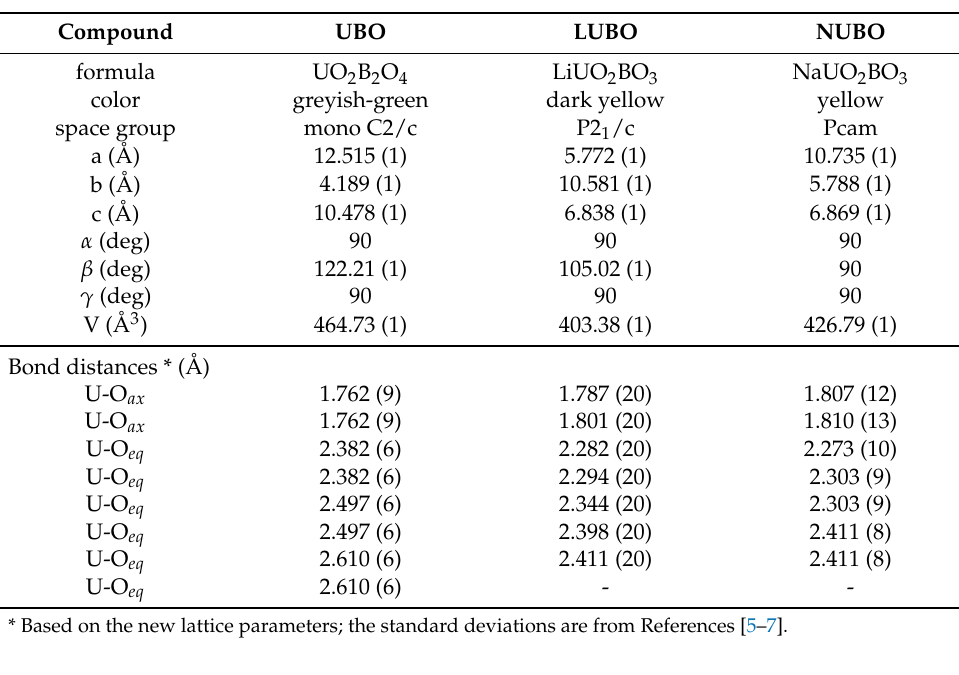
Table 1. Crystallographic data for UO 2 B 2 O 4 ( UBO ), LiUO 2 BO 3 ( LUBO ) and NaUO 2 BO 3 ( NUBO ).